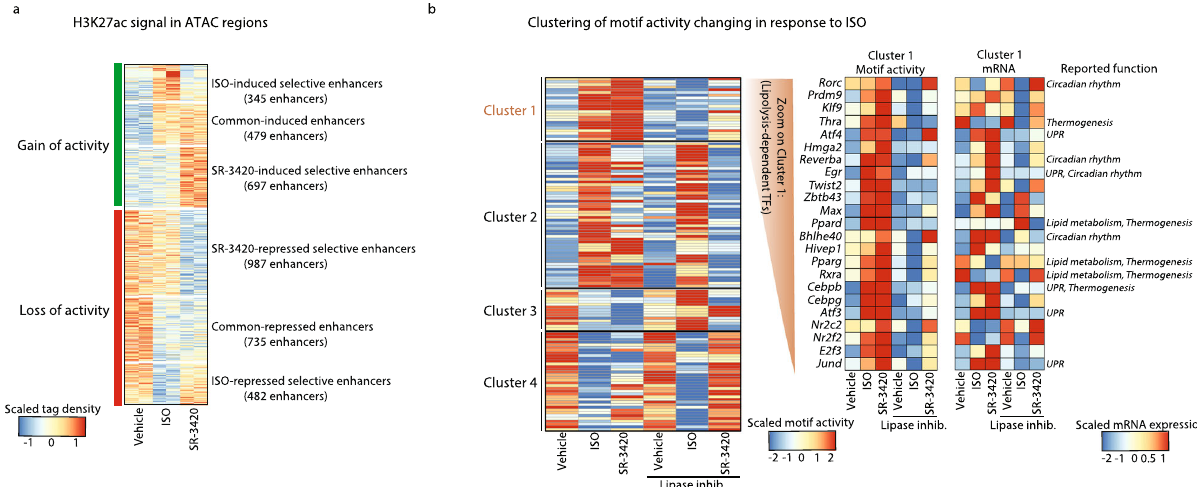
Fig. 4 Machine-learning strategy infers transcription factors mediating the transcriptional effects of ISO and lipolysis. Mouse in vitro differentiated brown adipocytes were pre-treated with 10 µ M Atglistatin (ATGL inhibitor) and 20 µ M CAY10499 (HSL inhibitor) for 1 h and subsequently with 100 nM isoproterenol (ISO) or 20 µ M SR-3420 for 3 h before harvesting for ChIP and ATAC. a Heatmap of H3K27ac levels in ATAC regions (ISO vs. vehicle and SR-3420 vs. vehicle: Log2FC ≥ 0.5 or Log2FC ≤ − 0.5) of mouse-brown adipocytes stimulated ISO or SR-3420 for 3 h before harvest. The results are 2 independent biological experiments. b K-means clustering of motif activity (calculated using IMAGE) of 127 transcription factor motifs, mRNA levels, and reported function of the 23 lipolysis-dependent transcription factor motifs in mouse-brown